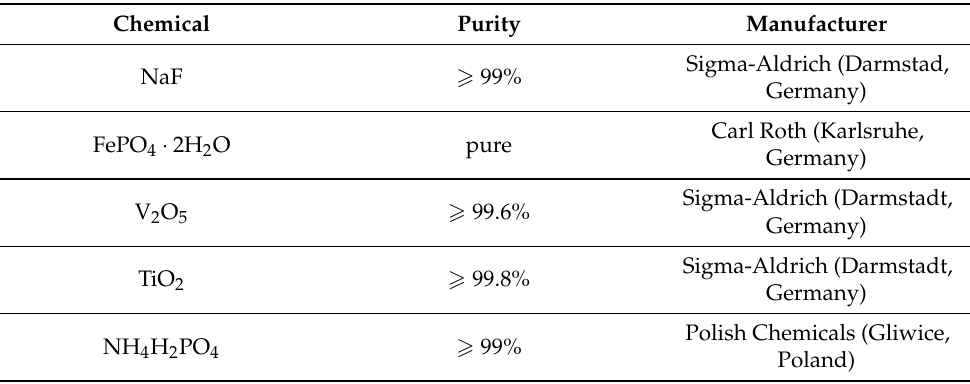
Table 2. Then, the batches in porcelain crucibles were put into an oven and presynthesized at 240 ◦ C for 4 h. For the compositions with M = Fe, pre-dried iron phosphate dihydrate was used. Because of the reactivity of NaF, which served as a sodium source, it was not added until the presynthesis step was finished. Thus, it required a second mixing and homogenizing process just before melting. NaF was added with 10% mol excess due to its evaporation at high temperatures. In the calculations, it was assumed that VOPO 4 , TiO 0.5 PO 4 compounds are created after the presynthesis [19]. Only in the case of TV sample, V 2 O 5 , TiO 2 and NH 4 H 2 PO 4 were presynthesized in one batch resulting in TiVO 1.5 PO 4 . Table 2. Chemicals used to synthesize the glasses; purity given by manufacturer. Chemical Purity Manufacturer Sigma-Aldrich NaF (cid:62) 99%